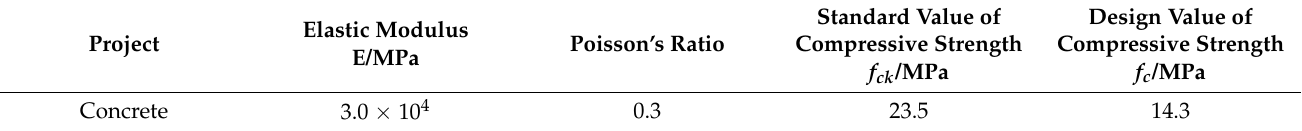
Table 6. Related parameters of C30 concrete.